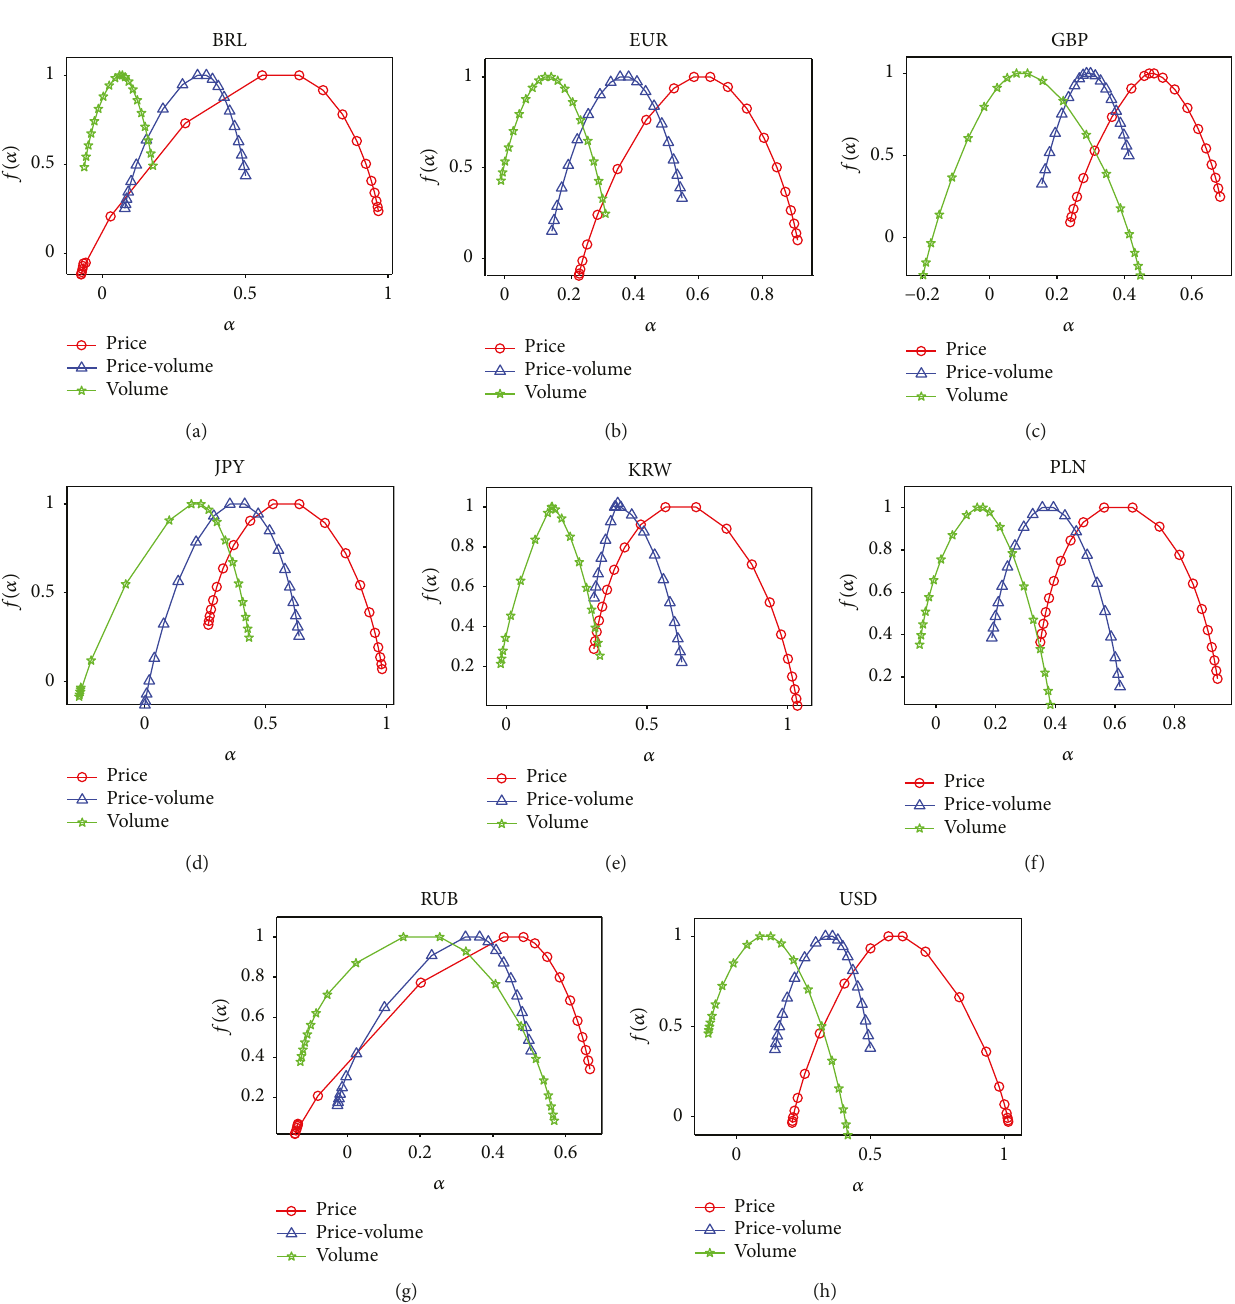
Figure 8: The multifractal spectrum f α as a function of α